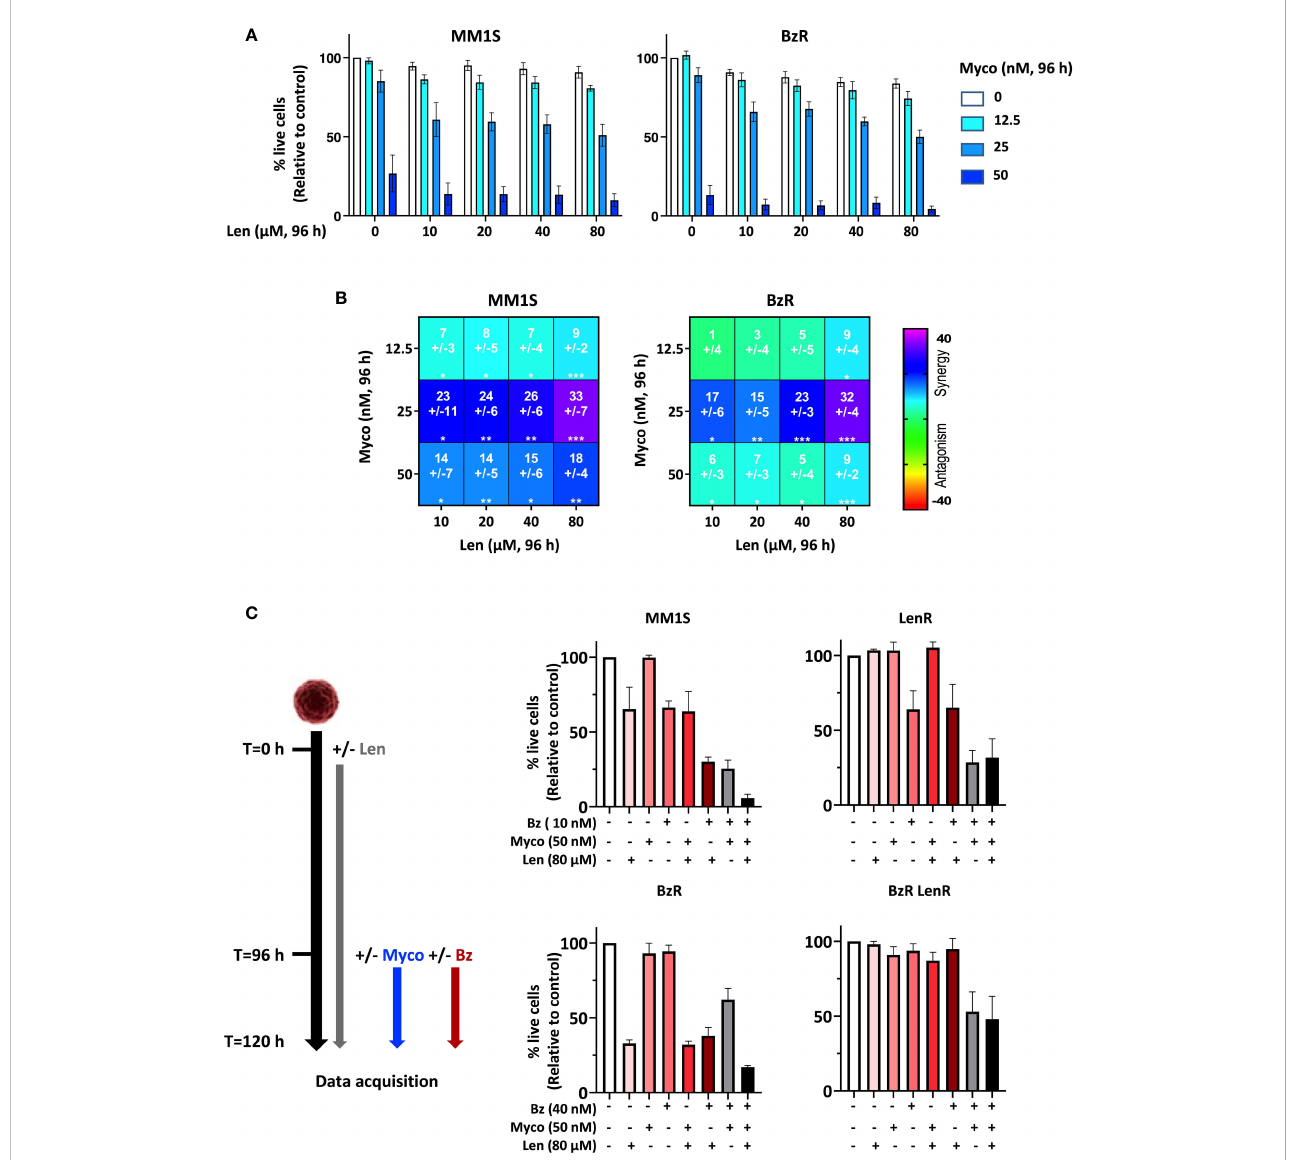
FIGURE 2 Anti-MM ef fi cacy of drug combinations including a Sec61 blocking agent. (A) Effect of Len+Myco combinations on the viability of MM1S (parental) and BzR daughter. Each cell line was treated as indicated with the different drugs or vehicle for 96h, and cell viability was assessed by exposure of Annexin V and incorporation of PI. Data are Mean % of live cells (relative to controls) from the cumulated results of 2 independent experiments with 3 technical replicates. (B) Synergy between Len and Myco in parental MM1S (left) or its BzR daughter (right), when treated as in (A) . The Loewe synergy score was calculated from the Data showed in (A) . Statistical signi fi cance was established by Student ’ s T test (*p < 0.05; **p < 0.01; ***p < 0.001, ****p < 0.0001). (C) Left: Diagram illustrating the experiment conditions. Right: Differential susceptibility of the four cell lines to mono-, bi- and tri-therapies (Right). Cells were treated as indicated with the different drugs or vehicle and cell viability was assessed by exposure of Annexin V and incorporation of PI. Data are Mean % of live cells (relative to controls) from the cumulated results of 3 independent